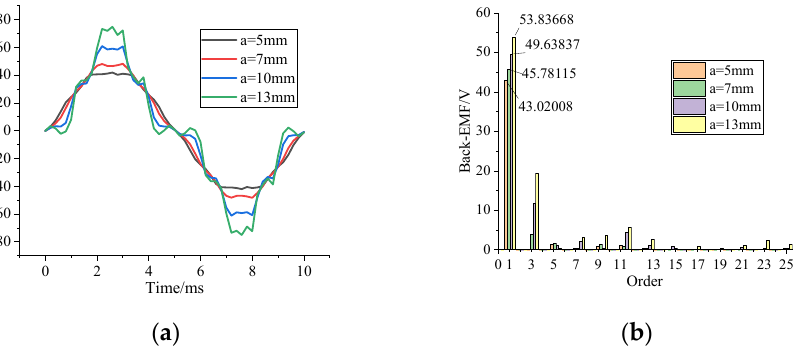
Figure 14. Back EMF with different lengths of magnetic barriers. ( a ) Waveform of back EMF; ( b ) harmonic spectra.